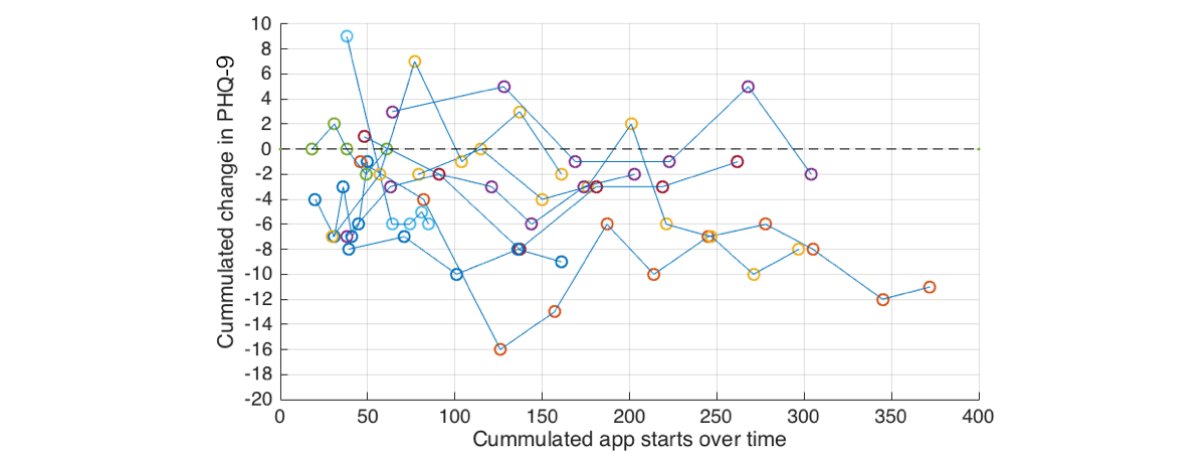
Figure 8. Scatter plot of cumulated app starts per subject over time and cumulated change in PHQ-9 values. Note: The development of PHQ-9 scores of individual subjects is indicated by connected points of the same color.